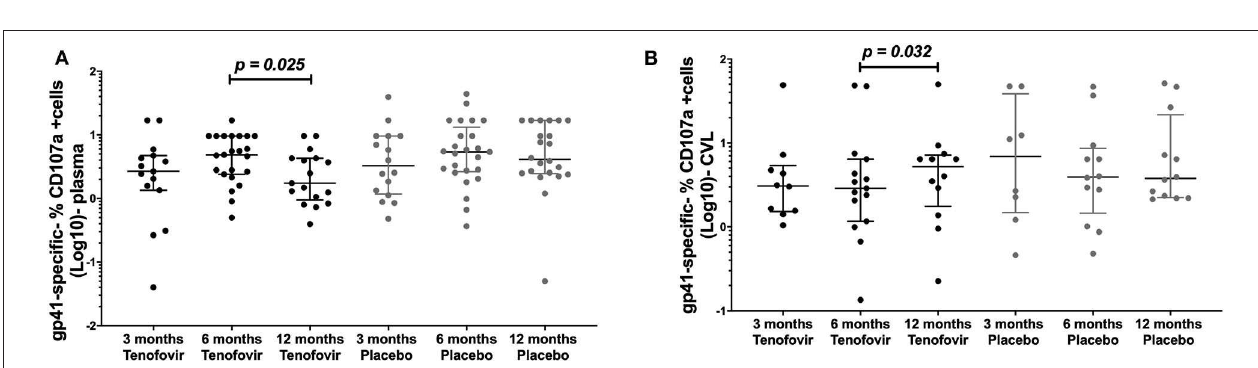
FIGURE 5 | Longitudinal analyses of NK cell activated ADCC (antibody-specific- %CD107a + cells [Log10]) in the plasma and GT (CVL) of women at 3 months, 6 months and 12 months, for the tenofovir and placebo arms for gp41. Analyses for cytotoxic activities (gp41-specific %CD107a + cells [Log10]) in the plasma on the left (A) for gp41 and the genital tract on the right to (B) for gp41. Solid lines indicate the minimum and maximum values of box and whisker plots, with black solid lines across the dots indicate the median at each time point for each study arm. Wilcoxon signed-rank tests were done to determine statistical differences between NK cell activated ADCC activities within each arm of the study, for each protein. Statistically significant values were defined as p < 0.05. No adjustments were made for multiple